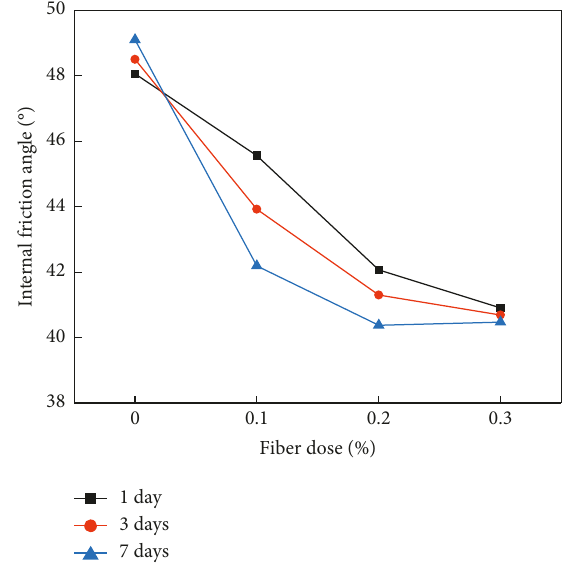
Figure 3: Variation of the angle of internal friction of cured remolded soil with fiber admixture at different curing